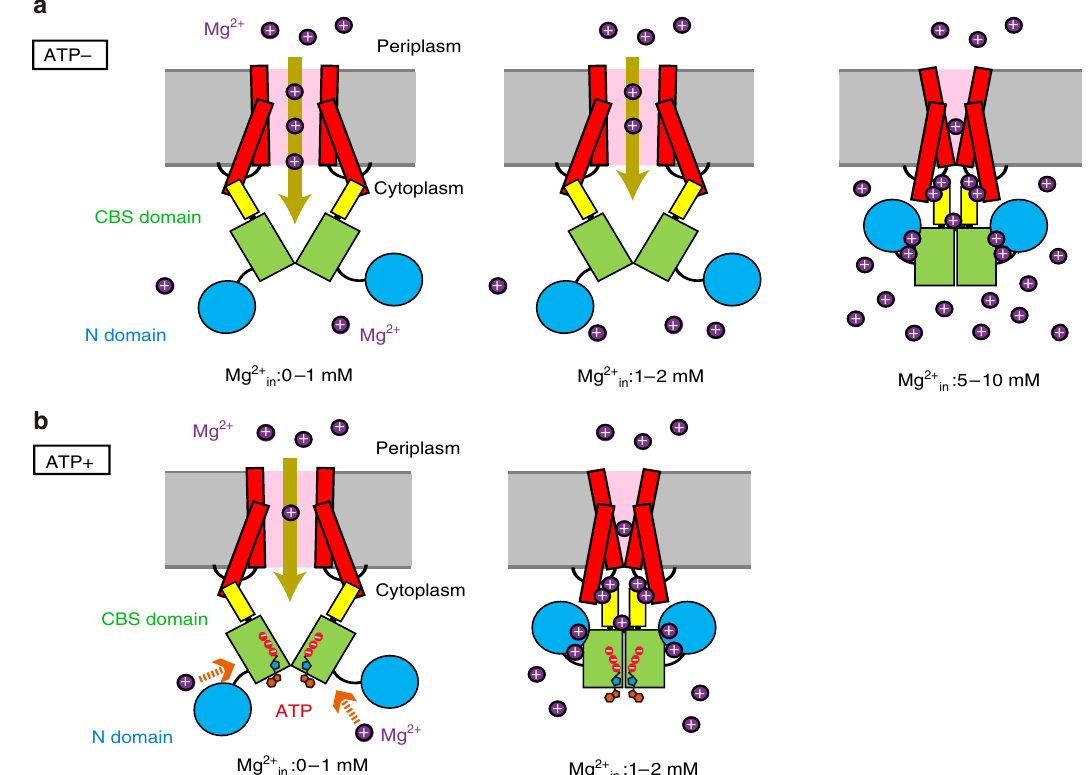
Fig. 7 Proposed functional role of intracellular ATP in the Mg 2+ -dependent gating of MgtE. A cartoon model of the proposed mechanism. The coloring scheme is the same as in Fig. 2. The brown arrows indicate the Mg 2+ in fl ux into the cells. Without ATP binding to the cytosolic domain, MgtE still opens when the intracellular Mg 2+ concentration (Mg 2+ in ) is above the physiological range (1 – 2 mM), and closes only at very high [Mg 2+ in ] (5 – 10 mM) a . With ATP bound to the cytosolic domain, MgtE closes when the intracellular Mg 2+ concentration is above the physiological range (1 – 2 mM) b . The orange arrows indicate the ATP-dependent attraction of Mg 2+ to the cytosolic